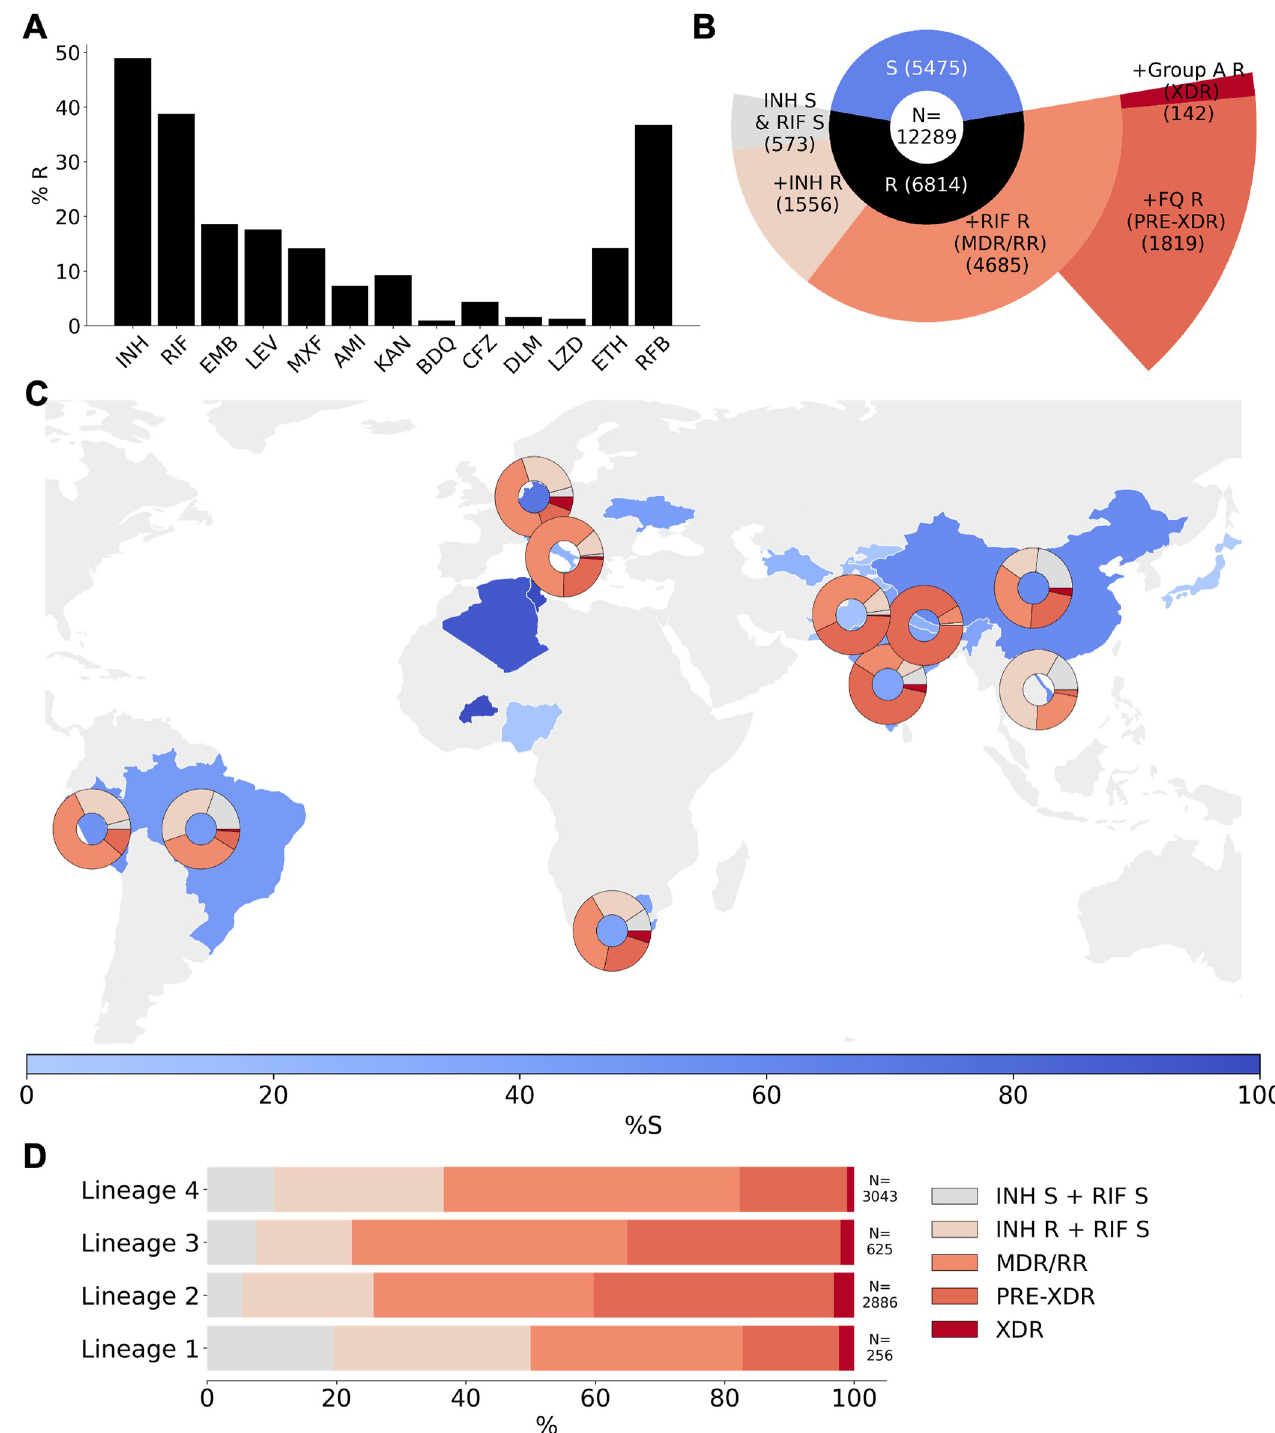
Fig 3. Drug phenotype data for the CRyPTIC compendium. (A) Frequency of resistance to each of 13 drugs in the data compendium. The total number of isolates with a binary phenotype (of any quality) for the corresponding drug is presented in Table 1. ( B) Phenotypes of the 12,289 isolates with a binary phenotype for at least 1 drug. ( C) Geographical distribution of phenotypes of 12,289 compendium isolates. Intensity of blue shows the percentage of isolates contributed that were categorised as susceptible to all 13 drugs (“%S”). Donut plots show the proportions of resistant phenotypes identified in (B) for countries contributing > = 100 isolates with drug resistance. (D) Proportions of resistance phenotypes in the 4 major Mycobacterium tuberculosis lineages. N is the number of isolates of the lineage called resistant to at least one of the 13 drugs. The base layer map in (C) was sourced from Natural Earth, which is in the public